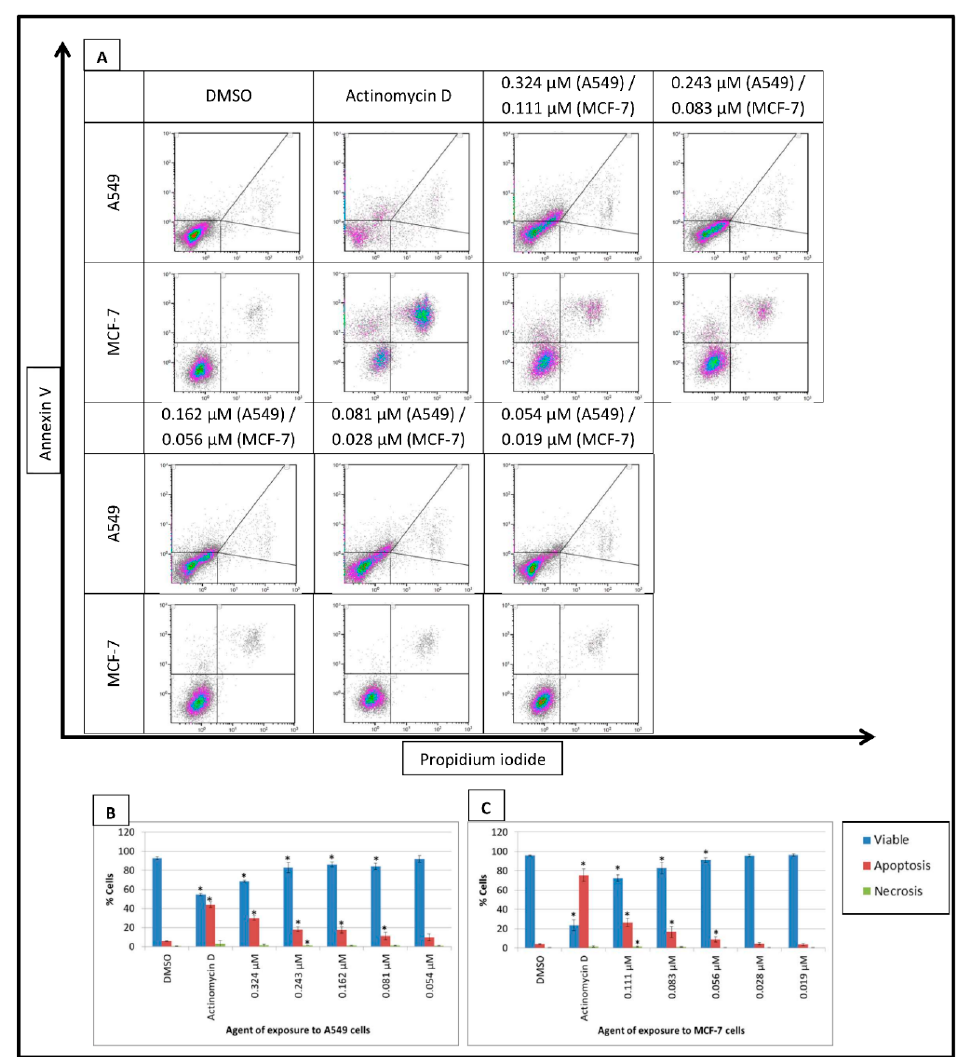
Figure A1. Annexin V-FITC flow cytometric density dot plots of A549- and MCF-7 cells exposed to an ESE-15-ol dose range. Annexin V-FITC (FL1) measured apoptotic cells and was plotted against propidium iodide (FL3) that measured necrotic cells ( A ). DMSO served as a vehicle control and actinomycin D as a positive control for apoptosis. The lowest concentration of ESE-15-ol that decreased cell viability significantly was determined to be 0.081 µ M for A549 cells and 0.056 µ M for MCF-7 cells. Graphical representations of A549 dot plots ( B ) and MCF-7 dot plots ( C ). Bars indicate average of three biological repeats, with standard deviation represented by T-bars. Statistically significant differences are indicated by * ( p -value <